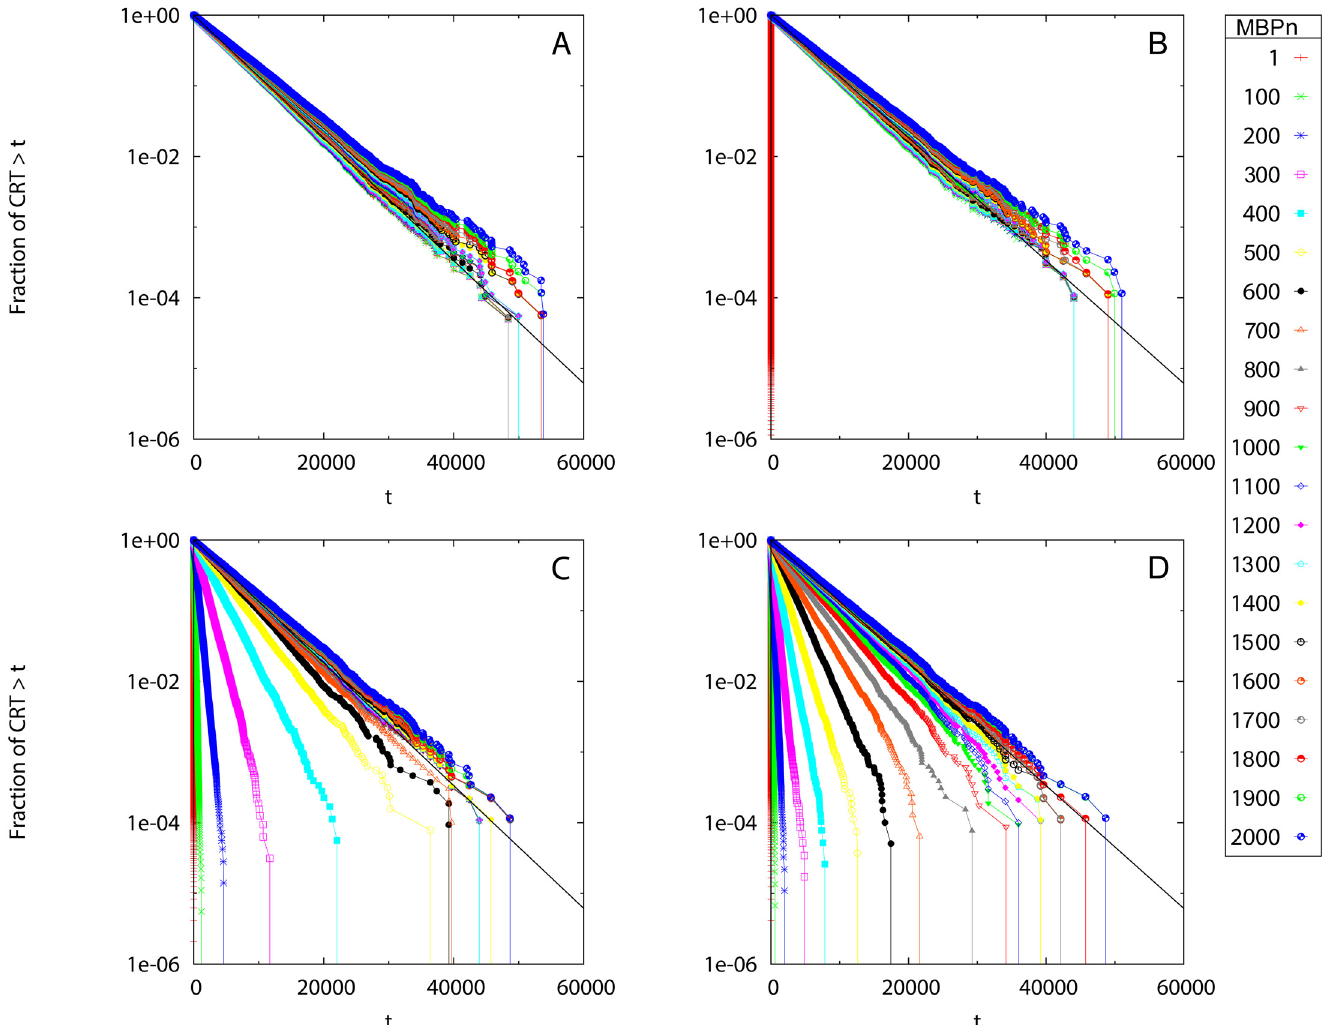
Fig 1. Scenario 1: Survival curves of CRTs. The survival curves are obtained for different values of MBP n (see legend) and different noise parameters: η = 1 (A), 0.1 (B), 0.01 (C) and 0.005 (D). The y axis is in logarithmic scale. Black line: the theoretical survival curve of residence times S ( t ) = exp( − 0.0002 t ).